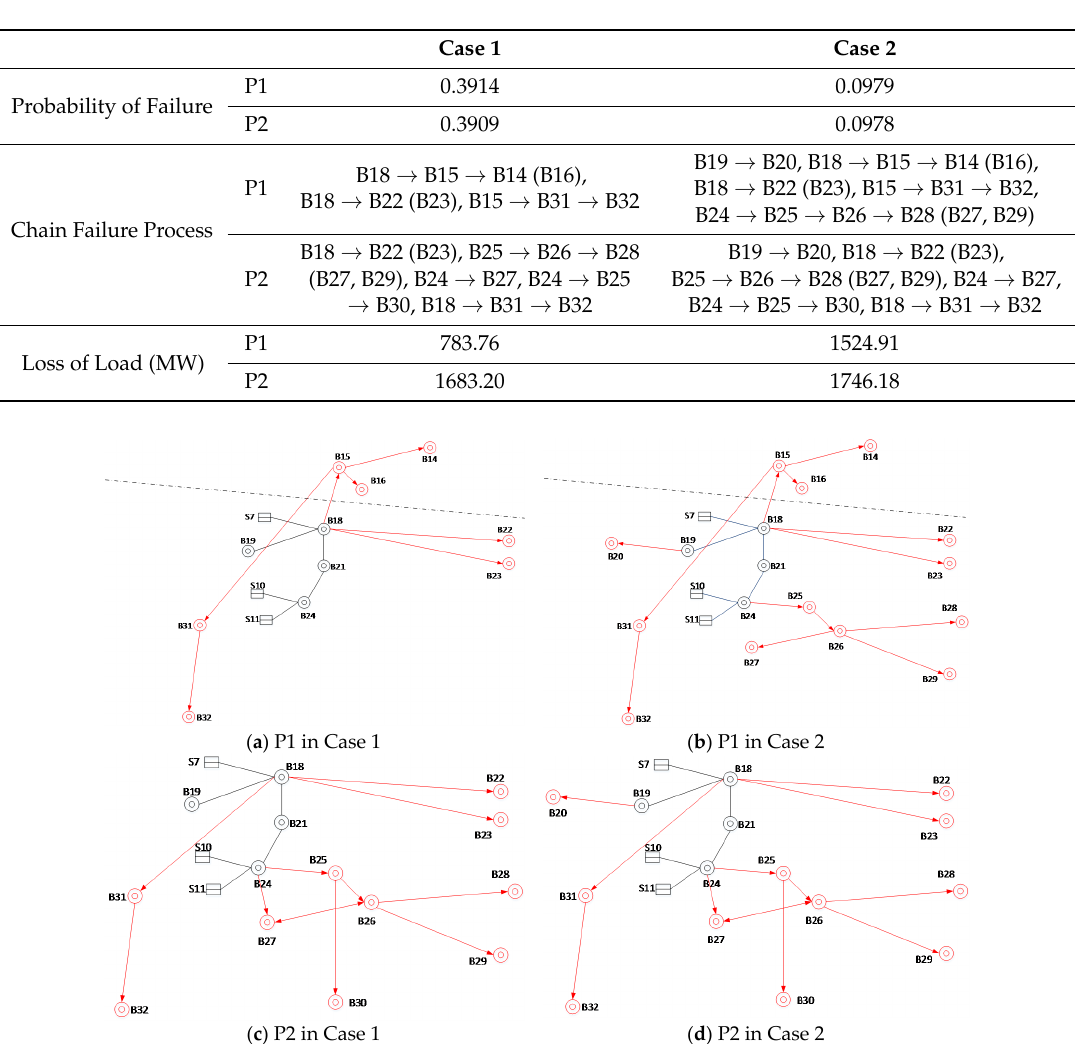
Table 2. Simulation results.